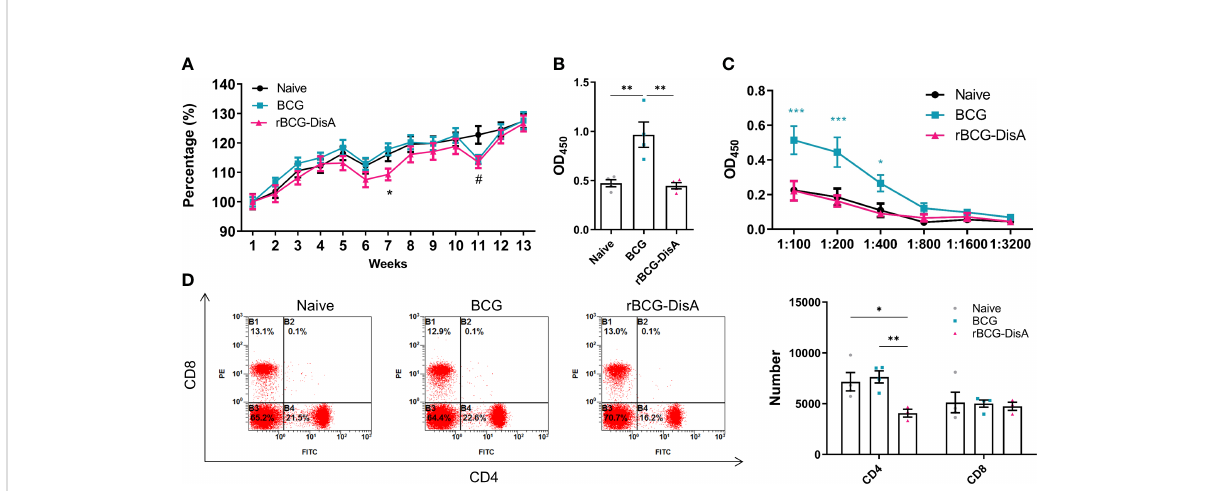
FIGURE 5 Adaptive immune response induced by rBCG-DisA vaccination. Male C57BL/6J mice were vaccinated with 1×10 6 CFU BCG and rBCG-DisA by i.v route. At 4- and 12-week post vaccination, immune responses were determined. Normal mice (Naïve) were used as control. (A) Dynamic monitoring of mice body weights at each week after immunization. Data were presented as a percentage of body weight to initial body weight ( n =3). (B) After 4 weeks of i.v immunization, BCG-speci fi c IgG levels in mice sera (1:200) were assayed by ELISA ( n =4). (C) After 12 weeks of i.v immunization, BCG-speci fi c IgG titers in sera of mice at indicated dilutions were assayed by ELISA ( n =4). (D) After 4 weeks of i.v immunization, CD4 and CD8 T cells in splenocytes were analyzed by fl ow cytometry of immunized mice (left). Numbers of CD4 and CD8 T cells in splenocytes were measured by fl ow cytometry ( n =4) (right). (Panel A , * P < 0.05 stands for rBCG-DisA v.s BCG, # P < 0.05 stands for rBCG-DisA v.s Naïve. Panel C , * P < 0.05 and *** P < 0.001 stand for rBCG-DisA v.s BCG/Naïve. Panel D , * P < 0.05, ** P <